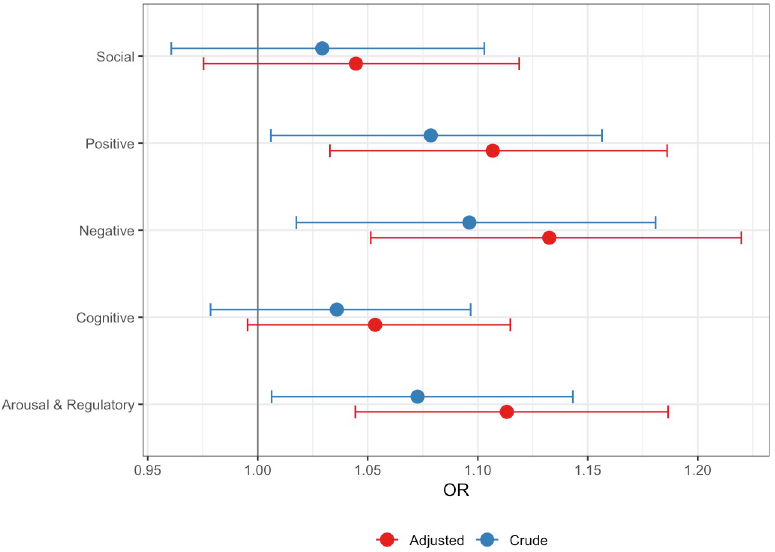
Fig 2. Crude and adjusted odds ratios (OR) for 90-day readmission risk, by change in estimated Research Domain Criteria score between discharge and